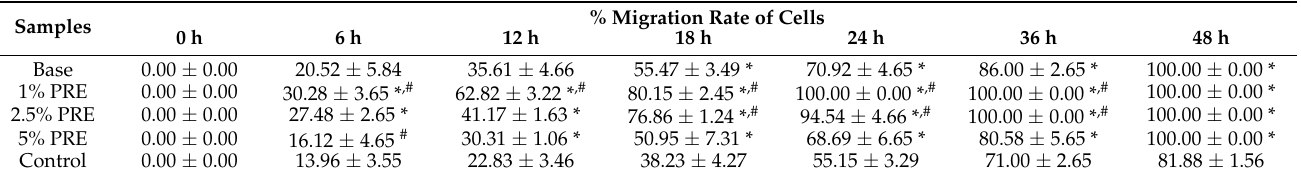
Table 7. Effect of the microemulsion base and microemulsions containing PRE at various concentra- tions on HDF cell